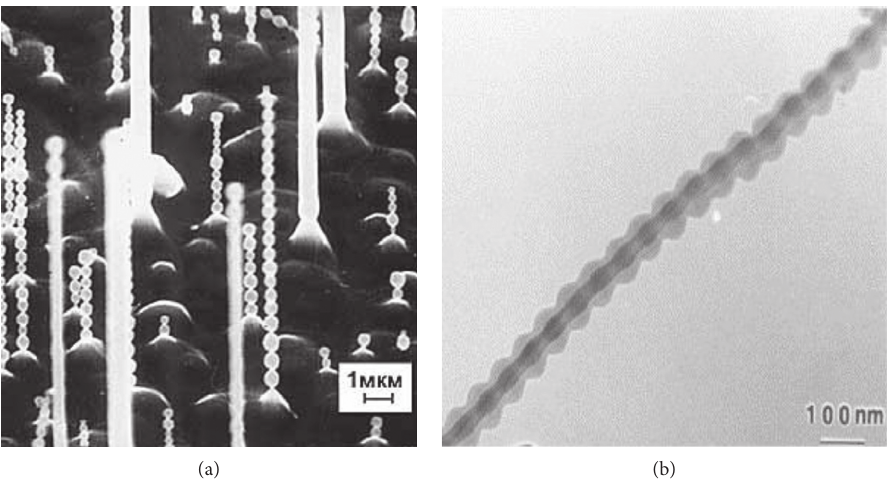
Figure 6: Radial periodic instability of Si NWs: (a) [32] and (b)